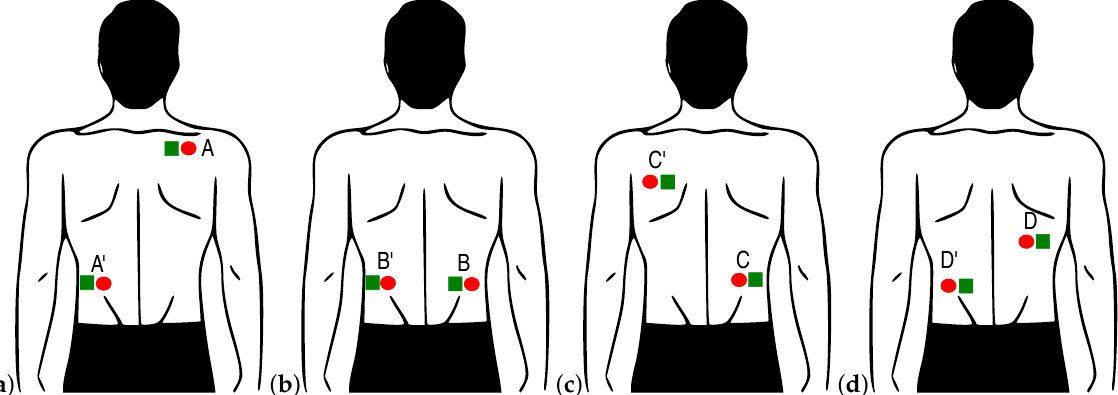
Figure 5. ( a – d ) Configuration of the leads (see text for details) used in the study for measuring ECG on the back (illustrative figures). Two signals were recorded simultaneously using contact (red circle) and non-contact (green square), respectively. Reference to sub-figures inside